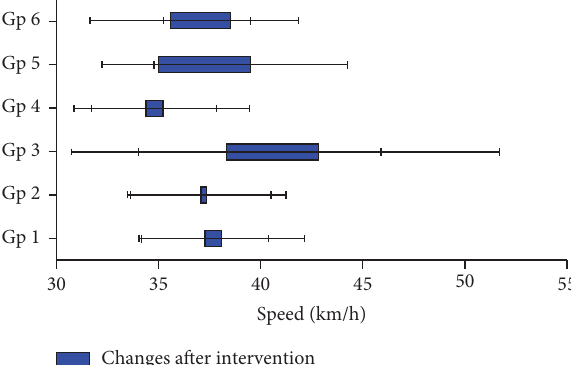
Figure 9: Changes in the mean speed on the whole drive after the intervention (the error bars represent the standard